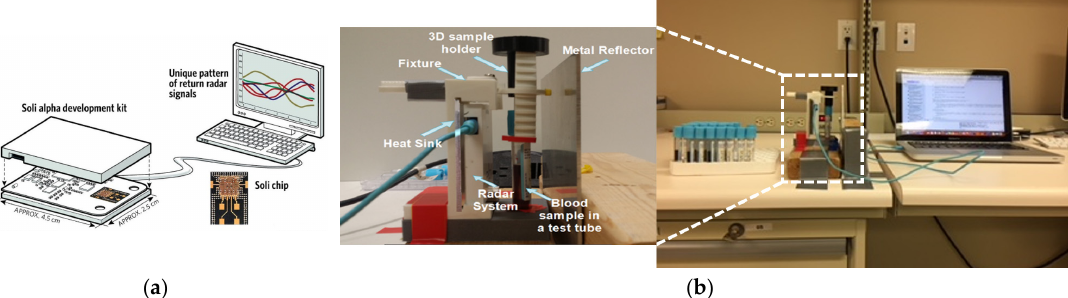
Figure 5. The radar experimental setup for glucose detection in blood test tubes: ( a ) Soli connection to PC; ( b ) The experiments setup showing the integrated system that employed mm-wave radar to detect changes in dielectric properties of samples with different glucose levels. PC interface where the collected raw data were monitored and processed using DSP algorithms for accurate identification.